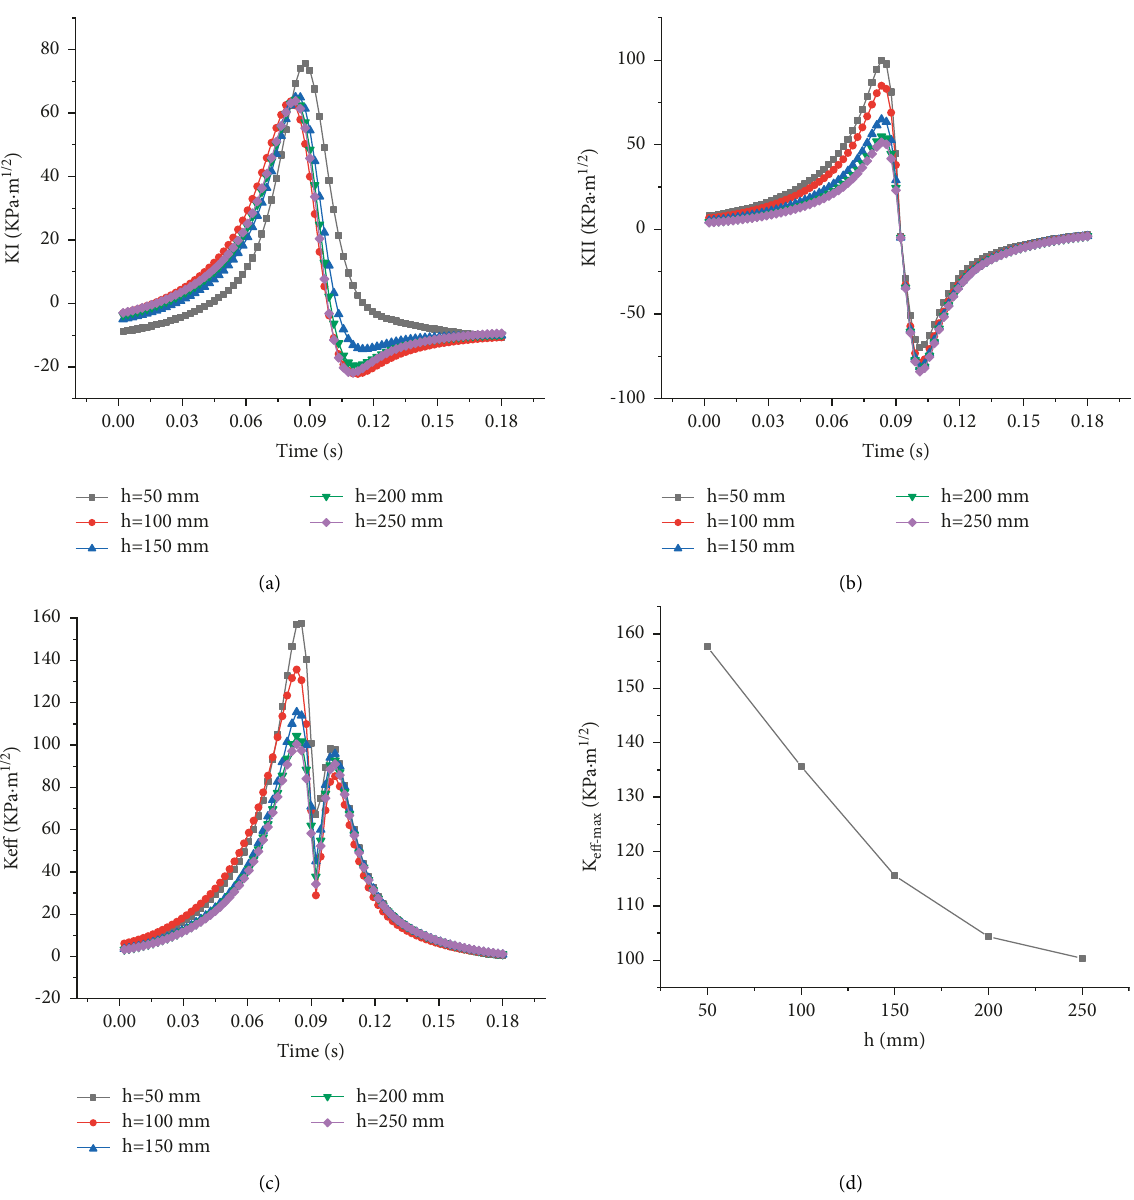
Figure 6: The SIF of nonpenetrating crack time history curve with various lengths. (a) KI; (b) KII; (c) Keff; (d)